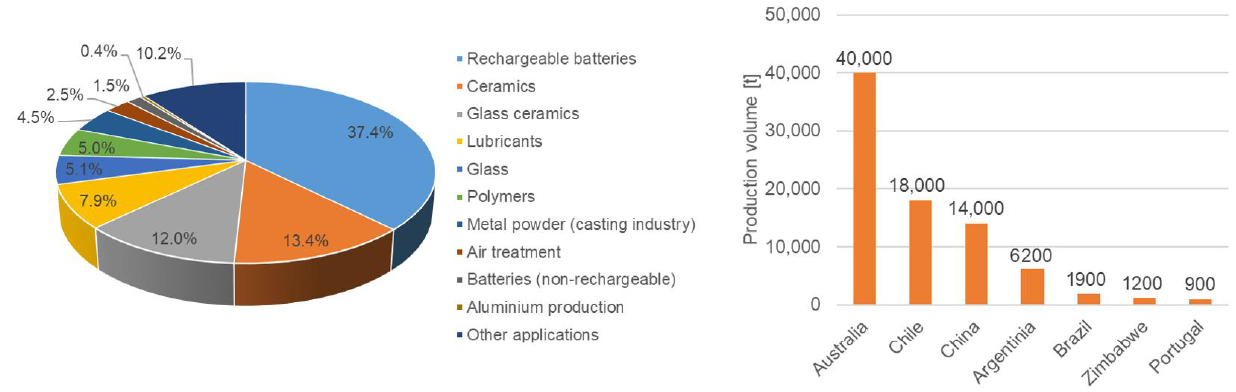
Figure 1. Production volume of lithium by countries for 2020 ( left ), and the most important application areas of lithium products ( right ).